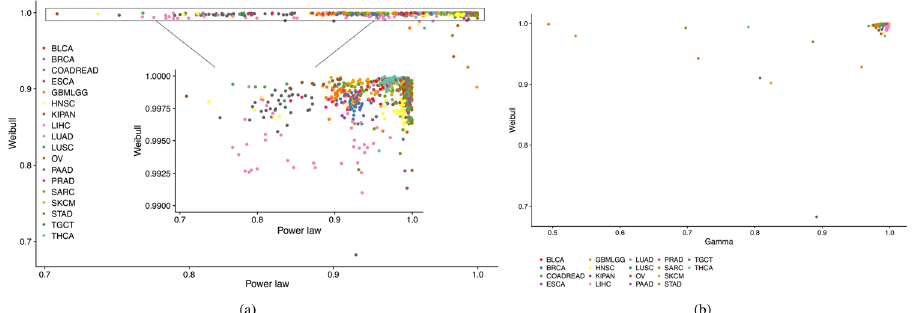
Figure 6. Goodness of fit for scaled Weibull function versus that of power law function ( a ), and scaled Gamma function ( b ). Each dot represents R 2 for one cancer subtype defined by the combination of cancer type and one factor such as diagnosis year, race, location and sex. Cancer types are color